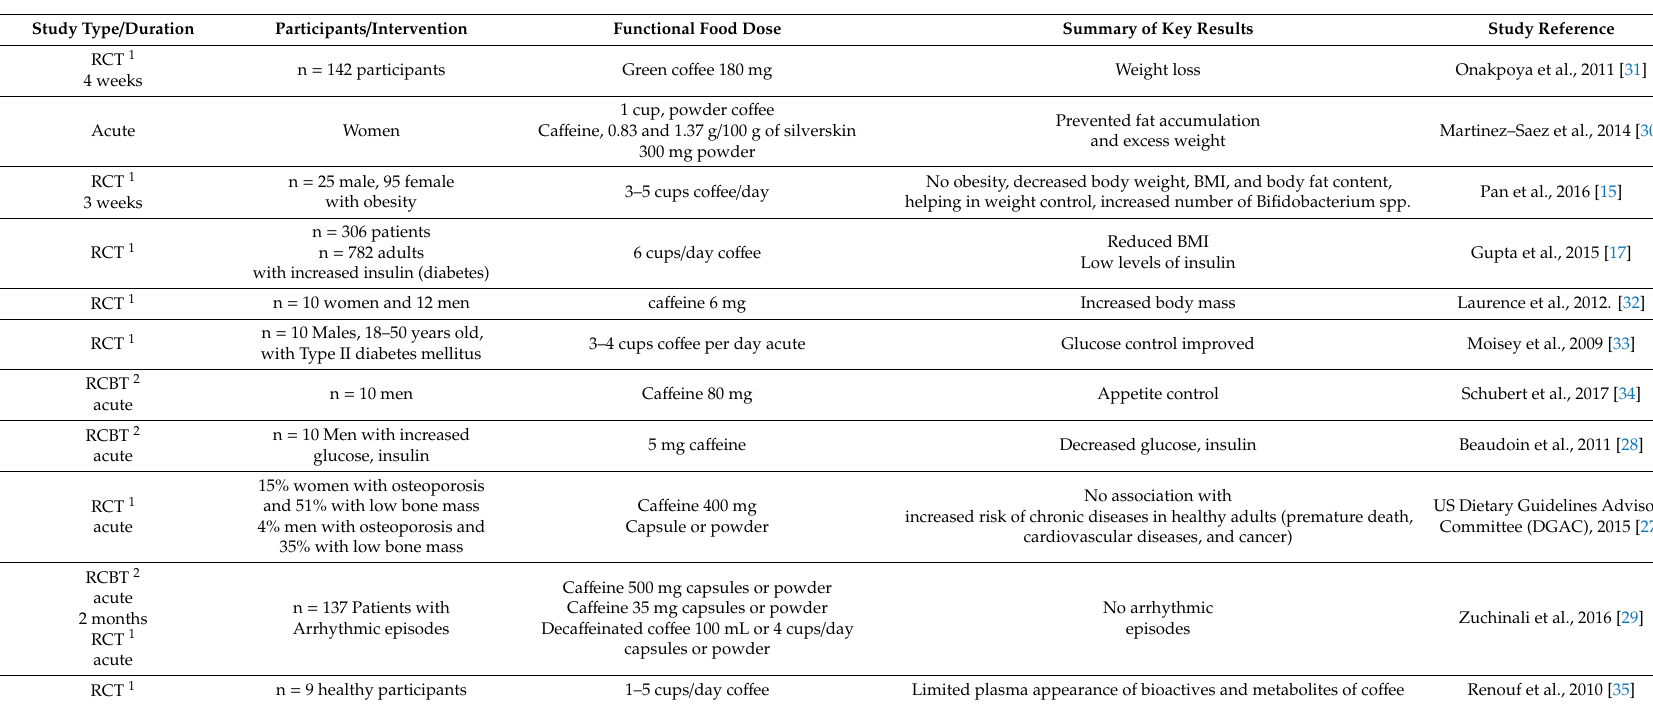
Table 2. Human interventional clinical studies about the possible e ff ect of co ff ee and ca ff eine on body weight control, obesity, and its metabolic